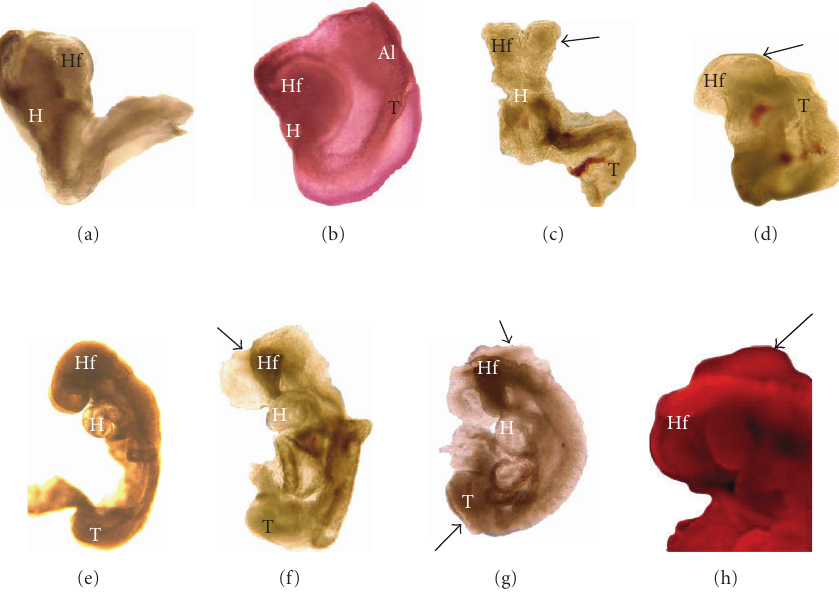
Figure 9: Control- and Gene-targeted embryos: nanog, geminin, Aggf1 , and Est1. (a) Control embryo. Sideview of an embryo exposed to pRed plasmid (no hairpin) on E6.5 and examined on E8.5, illustrating the normal appearance of the head folds (Hf), somites, and unturned body axis. (b) Nanog shRNA. Embryo exposed on E6.5 to shRNA targeting nanog , illustrating the typical lack of development of the head folds (Hf) and posterior region in the tail bud (T). Somites have also failed to segregate normally. (c) and (d) We carried out a di ff erential display RT-PCR screen of genes induced in D3 ESC by noggin exposure, then targeted two using tail vein injection of shRNAs. (c) Aggf1 -targeted embryos failed to implant normally and the primitive ectoderm often delaminated into the amniotic cavity. Hemorrhages are present within the embryo; there are striking abnormalities of turning and posterior development in the rare embryo that survived to E8.5. (d) Est1-targeted embryo. There were anomalies of primitive streak organization in these embryos. They also often failed to turn to adopt the fetal position and exhibited abnormalities of the node. (e) pRed control. Sideview of an E8.5 pRed (no hairpin) control. This embryo is beginning the turning process, the body axis is elongated, neural folds are fused in the anterior (head fold, Hf) region, although the posterior neuropore remains open in the tail bud (T). (f) Wnt8b -targeted embryo illustrating the shortened axis and open neural folds typical of these embryos. (g) and (h) Geminin shRNA. An embryo exposed to geminin shRNA on E6.5 and examined on E8.5. There are very characteristic midbrain (upper arrows) and posterior neuropore (lower arrow in (g)) defects in these embryos, which exhibit widespread DsRed fluorescence (H). All embryos are oriented with anterior toward the left. Al: allantois, H: heart, Hf: head folds, T: tail bud. Arrows indicate open neural